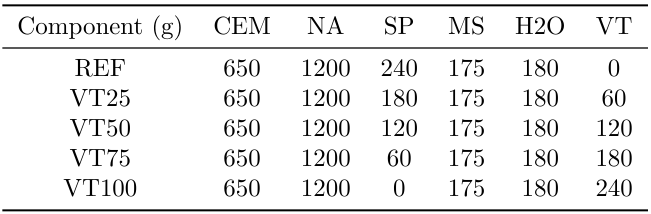
Table 1. Recipe of the tested HPC mixtures.